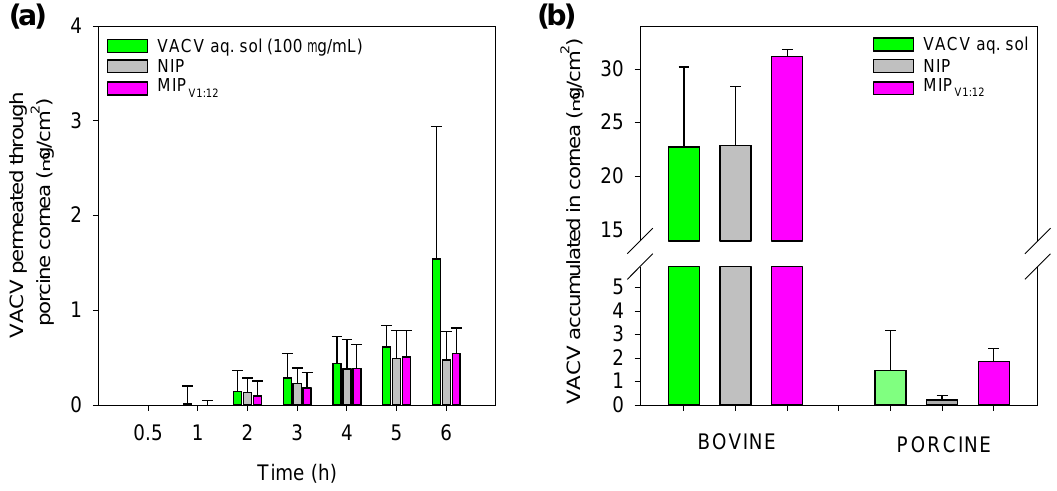
Figure 8. Amounts of VACV permeated through porcine cornea ( a ) and accumulated in bovine or porcine cornea ( b ) when applied as a drug solution or as VACV-loaded NIP and MIP V1:12 hydrogels. Mean values ( n = 3); error bars indicate standard deviations.